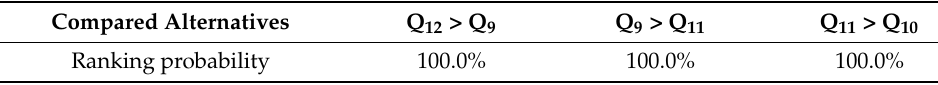
Table 11. Ranking probabilities of compared alternatives.